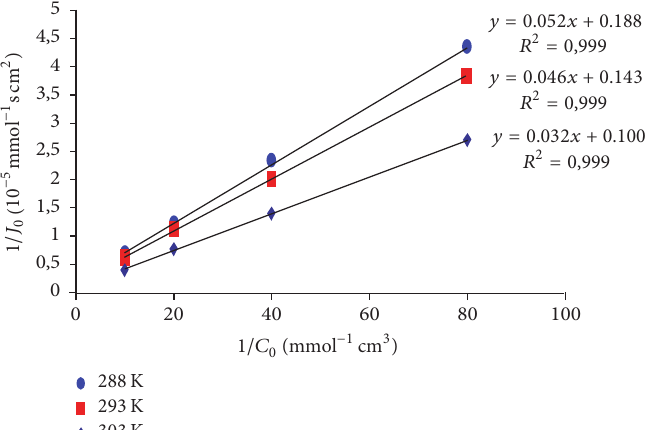
Figure 13: Lineweaver-Burk straight lines relating to the influence of temperature on the microscopic parameters for extracting VO 2+ ions by SLM-MC membrane. [H 3 O + ] = 1M, [MC] = 10 −2